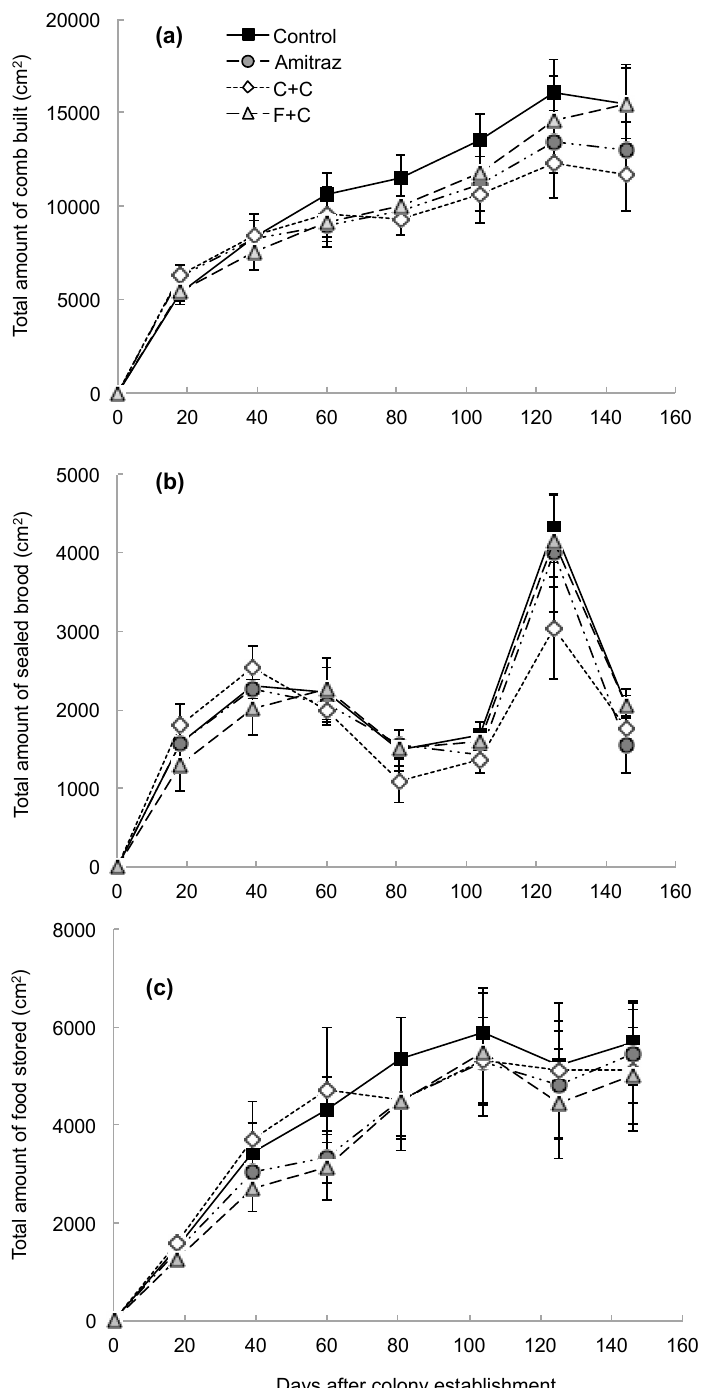
Figure 1. Growth patterns (panels a – c ) for new honey bee colonies established on 18 May 2017 (day 0). Of the 30 total colonies, seven were established on wax foundation treated with amitraz, seven with chlorothalonil and chlorpyrifos (“C+C” treatment), seven with tau ‐ fluvalinate and coumaphos (“F+C” treatment), and nine served as controls that were established on pesticide ‐ free wax foundation. Colonies were sampled every three weeks through 17 October 2017 (day 146) for a total of seven sampling periods. Data are presented as the mean ± S.E.M.